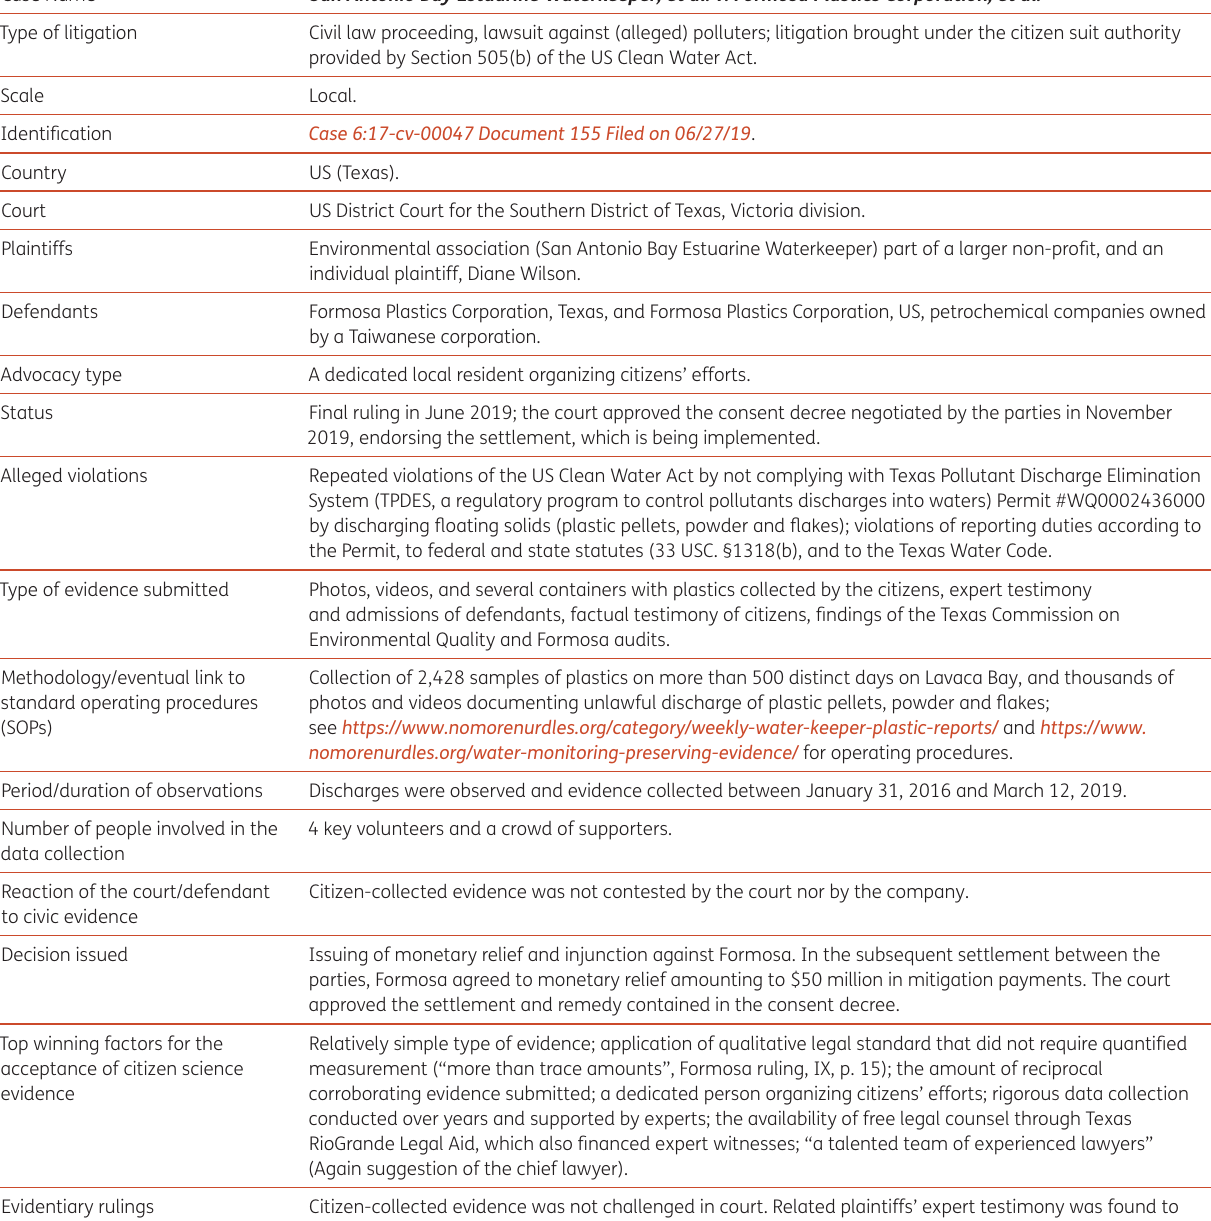
Table 1 Summary of the key elements of the